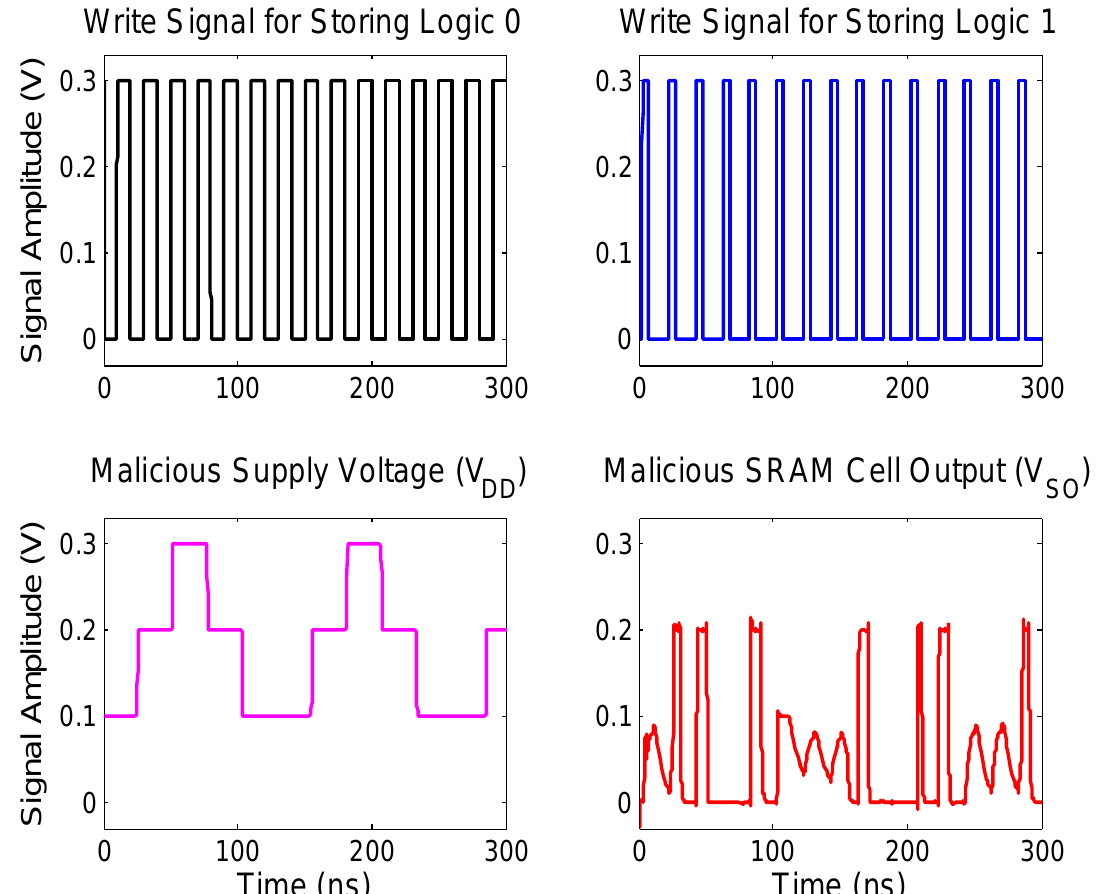
Figure 5. The circuit operation of malicious SRAM